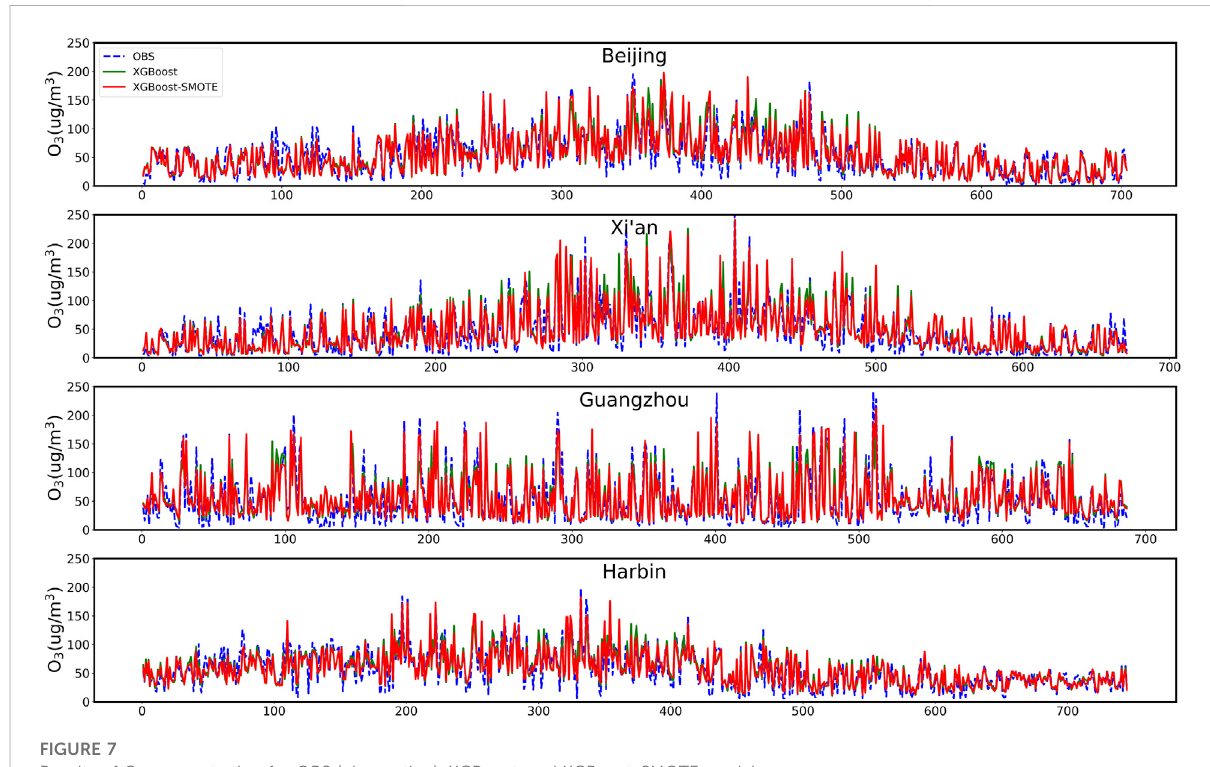
FIGURE 7 Results of O 3 concentration for OBS (observation), XGBoost, and XGBoost-SMOTE model.